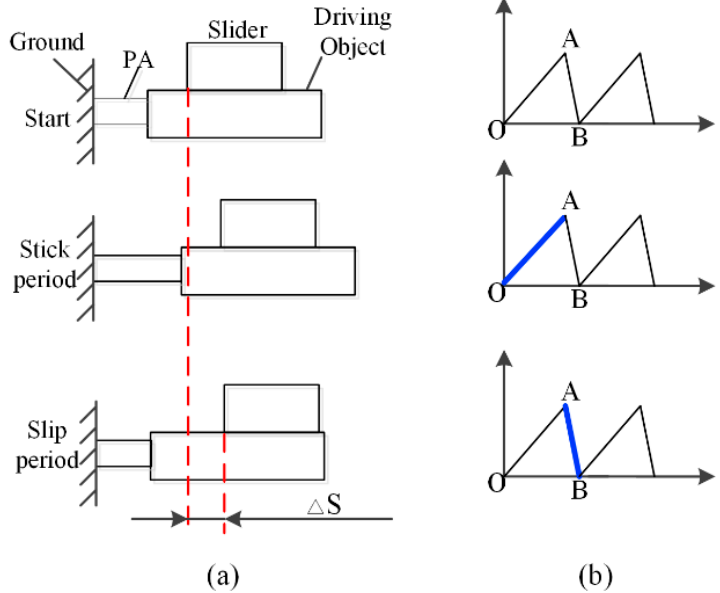
Figure 1. ( a ) Principle of stick-slip driving; ( b ) conventional driving signal. Reproduced with permission from